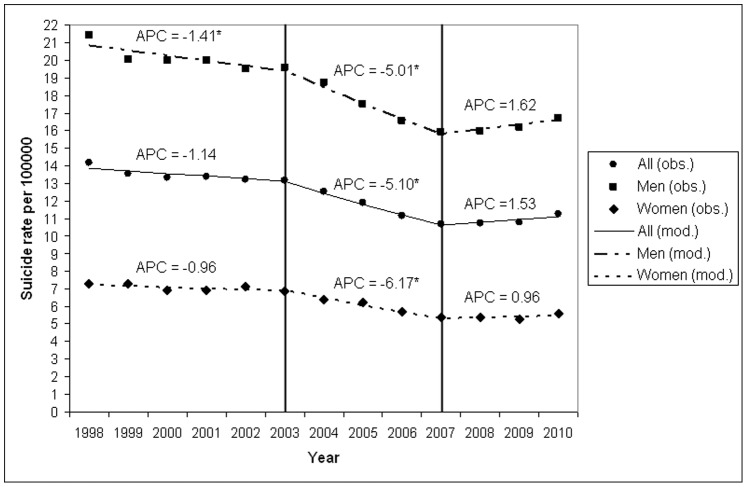
Suicide mortality in Germany (1998–2010).Based on the results of joinpoint regression analyses, age-adjusted suicide rates in all subjects (no symbol), males (squares) and females (rhombi), corresponding trends (lines) and Annual Percentage Changes (APC) are given. * p<0.05.